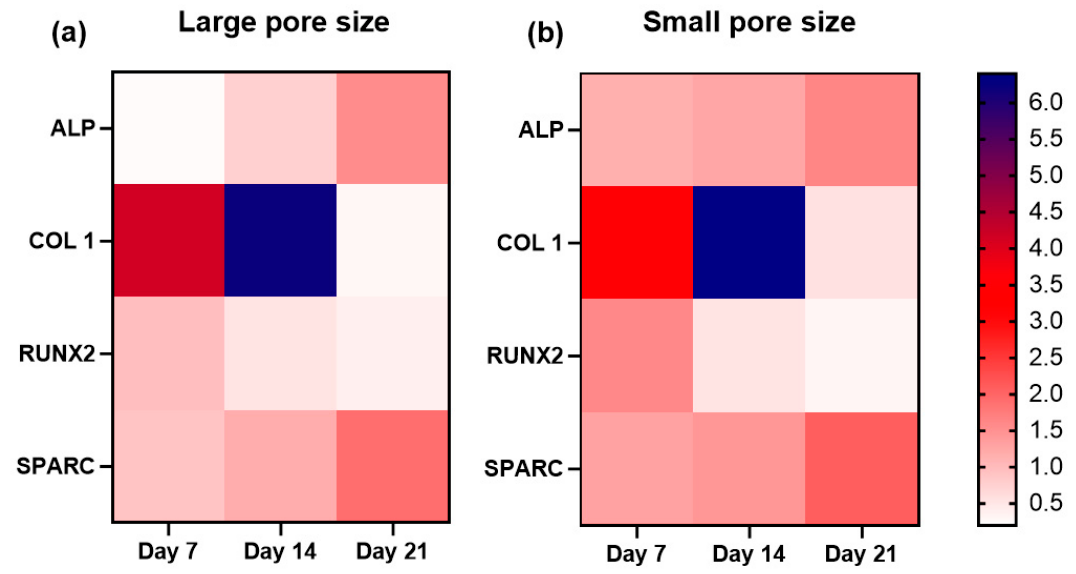
Figure 8. Heat map of gene expression of small ( a ) and large ( b ) pore size SiOC(N) ceramic scaffolds. n = 8.